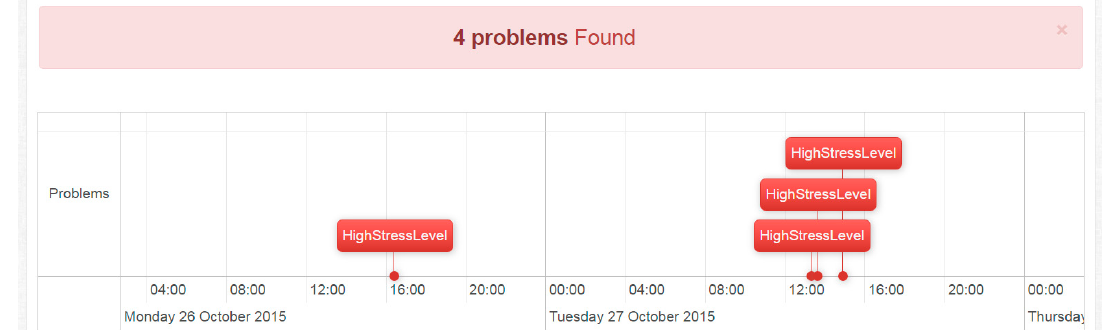
(“Threshold”) for each user (anonymized drop-down menu) and time period (“From”–“To” fields).